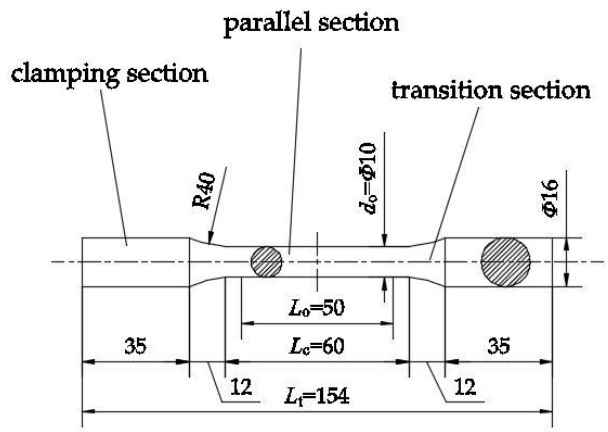
Figure 1. Design of specimens (Units: mm). Table 1. Specimen description.